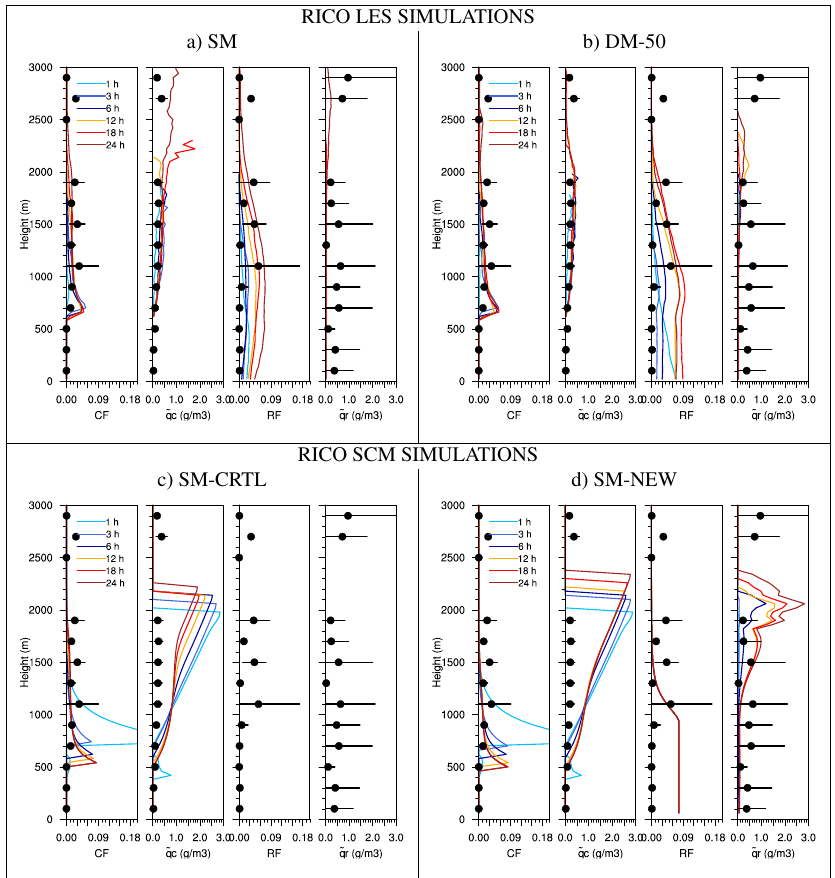
Figure 11: Same as Fig. 6 for RICO.